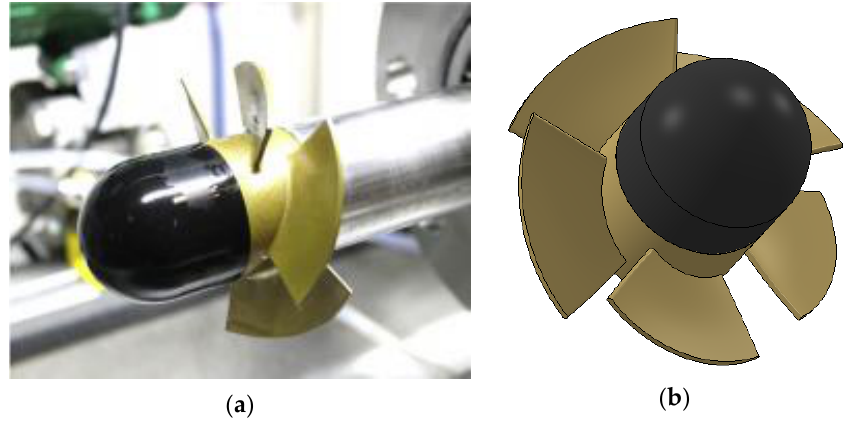
Figure 5. Five-blade propeller turbine. ( a ) Prototype [26]; ( b ) obtained 3D geometry for validation.